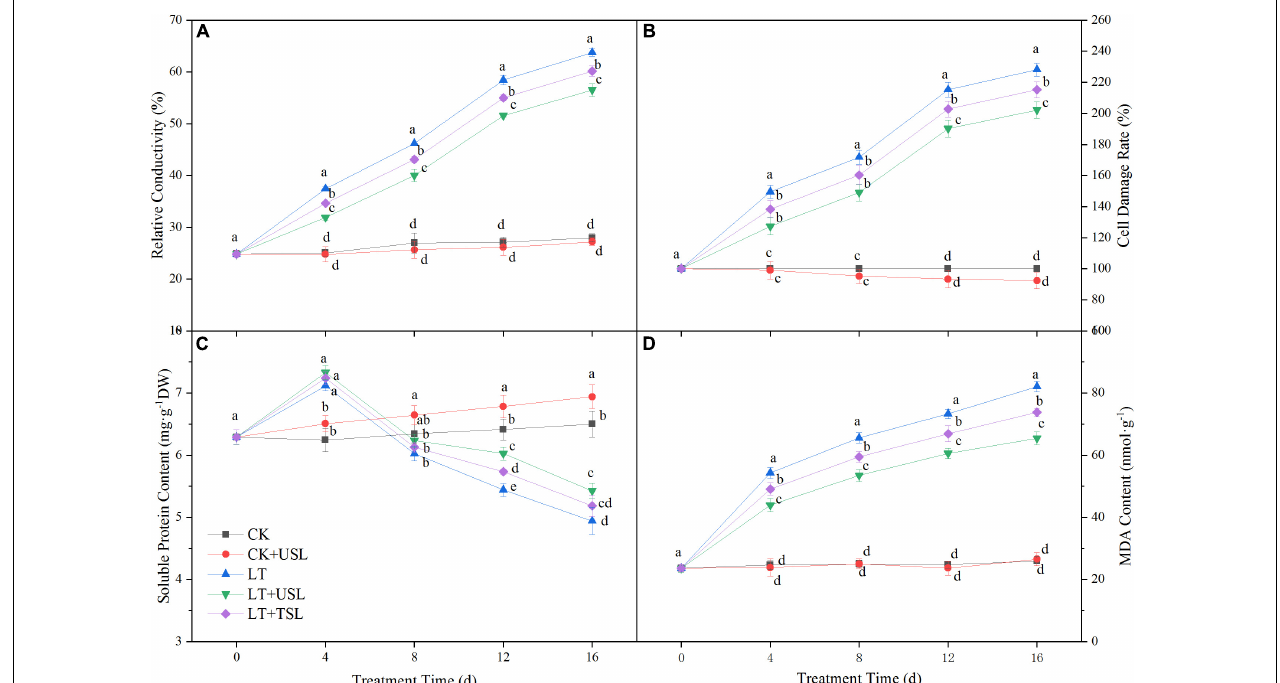
FIGURE 7 | Effects of USL on the membrane lipid peroxidation of tomato seedlings under LT stress. (A) Relative conductivity and (B) cell damage rate reflect the status of plant membrane system; (C) Soluble protein content and (D) MDA content reflect the lipid peroxidation degree of plant membrane.